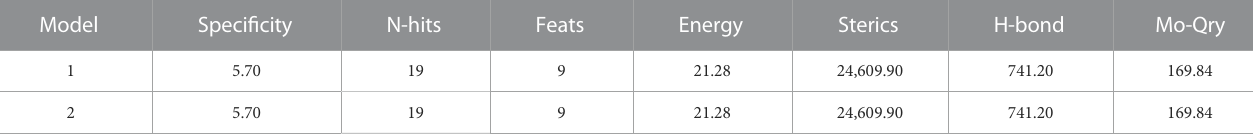
TABLE 1 Assessment parameters of the pharmacophore theory produced by the GALAHAD module.